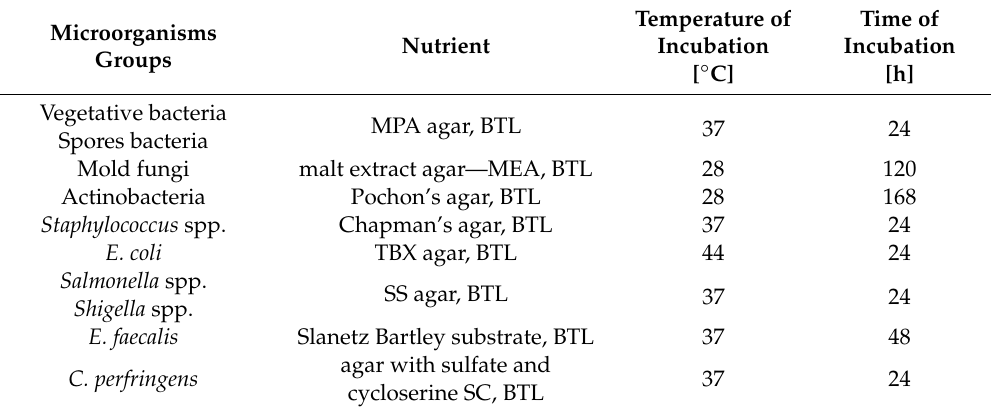
Table 1. Incubation parameters of the analyzed groups of microorganisms. Microorganisms Groups